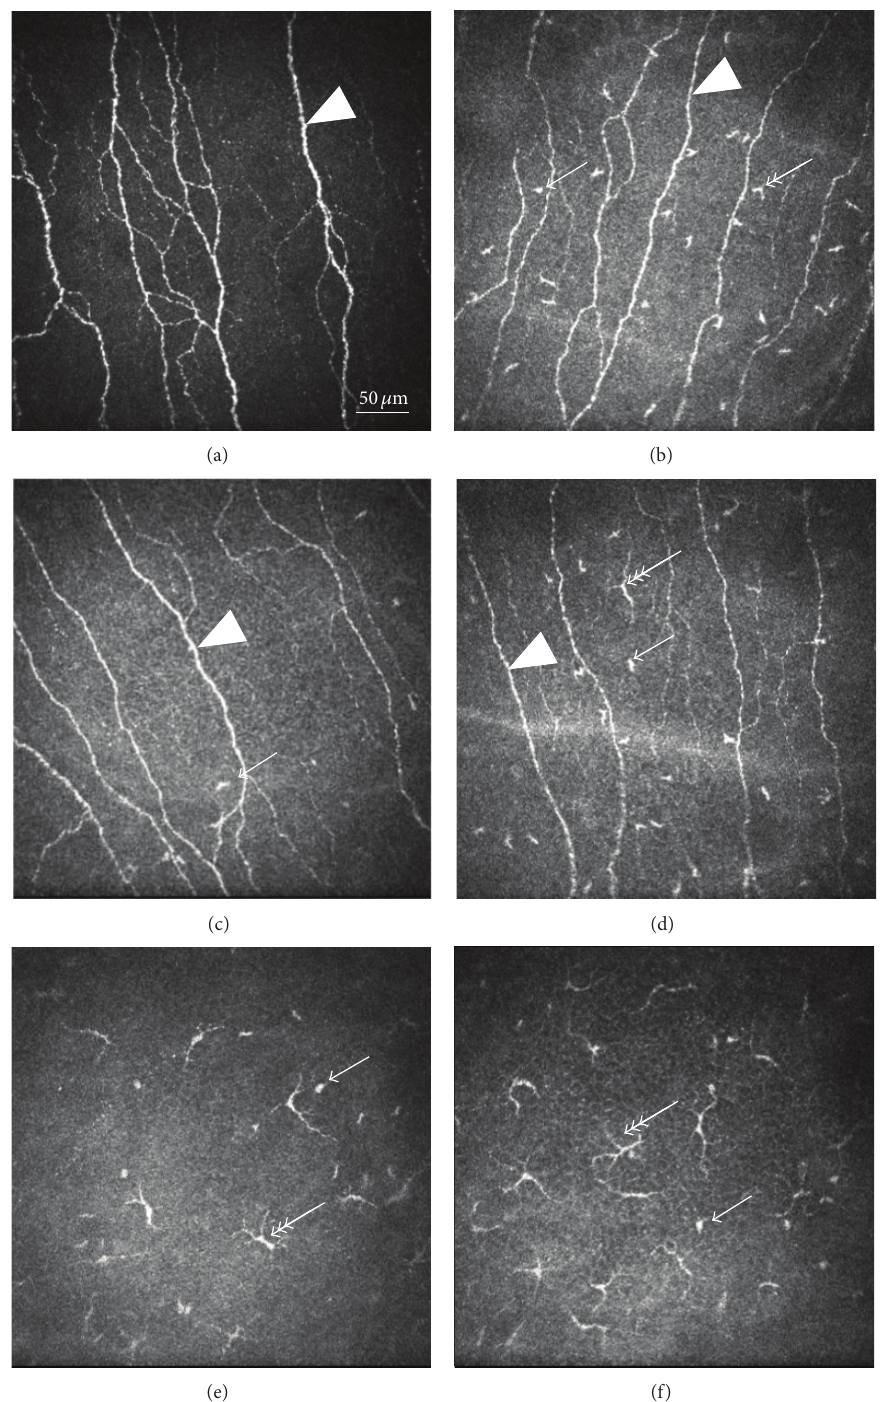
Figure 1: In vivo confocal microscopic images of corneal dendritic (Langerhans) cells (LC). Size of all images is 400 𝜇 m × 400 𝜇 m. Bar indi- cates 50 𝜇 m. Simple arrow indicates LC without dendrite (LCM score = 1, probably immature), double arrow corresponds with LCM score = 2 (dendrite not longer than cell body), and triple arrow demonstrates LC with long dendrites (LCM score = 3, dendrite longer than cell body, sign of activation). Arrowhead points to subepithelial nerve plexus. (a) Image of the central cornea of a healthy volunteer. Note the normal subepithelial nerves. No LC is visible in the centre of the cornea (LCM score = 0) (depth of image from surface 43 𝜇 m). (b) Central cornea of a patient with SLE. Density of LCs is larger than that in normal corneas. Most of the LCs are of LCM score 1, but some are of LCM score 2 (depth of image from surface 48 𝜇 m). (c) Peripheral cornea of the same control eye as in Figure 1(a). Note that some LCs can be observed (only of LCM score 1). (d) Peripheral corneal image of the same patient as in Figure 1(b). Mixed population of LCs of LCM scores 1 and 3 can be seen (depth of image from surface 46 𝜇 m). (e) Image taken anteriorly from subepithelial nerve fibres (37 𝜇 m from surface) of the central cornea of an SLE patient. A large number of LCs are of LCM score 3 and some are of LCM score 1. (f) Peripheral cornea of the same patient as in Figure 1(e) (36 𝜇 m from the surface). Density of LCs (predominantly LCM Score 3) is larger than that in the centre of the same